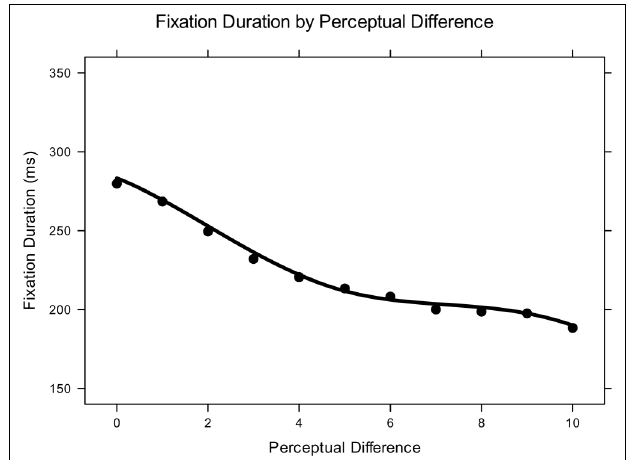
FIGURE 5 | Overall effect of perceptual difference on fi xation duration. Overall means and model-fi tted